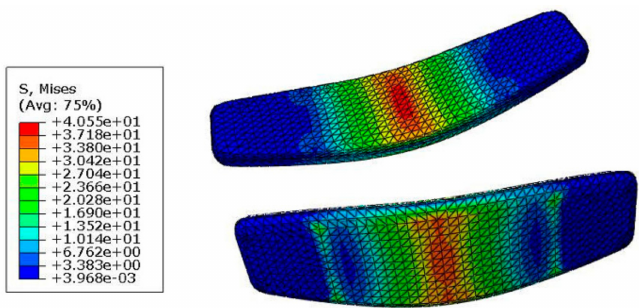
Figure 12. Von Mises stress contour of the board with the uniform honeycomb core.